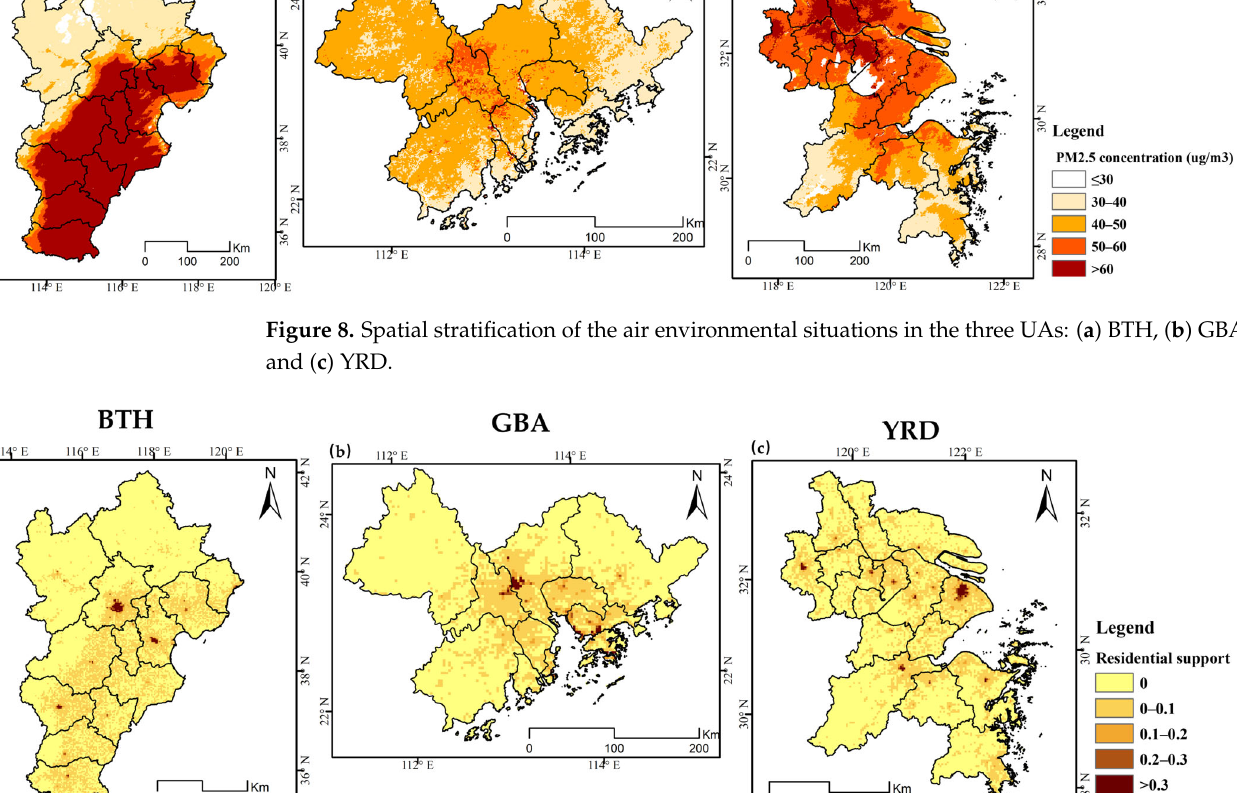
Figure 8. Spatial stratification of the air environmental situations in the three UAs: ( a ) BTH, ( b ) GBA, and ( c ) YRD.